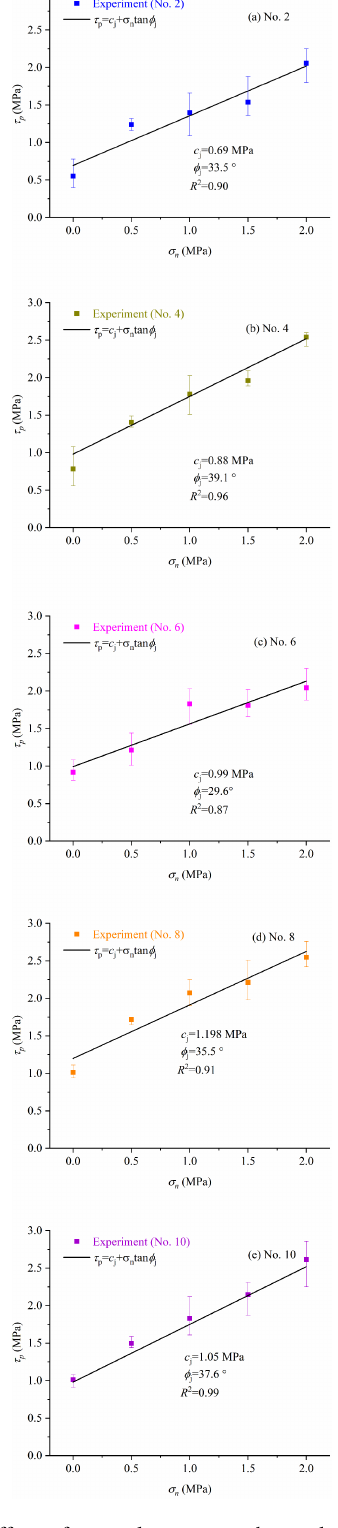
Figure 17. Effect of normal stress on the peak shear strength of ice-filled joints. Experimental conditions: T =− 15 ◦ C, v = 0.2mmmin − 1 and d =